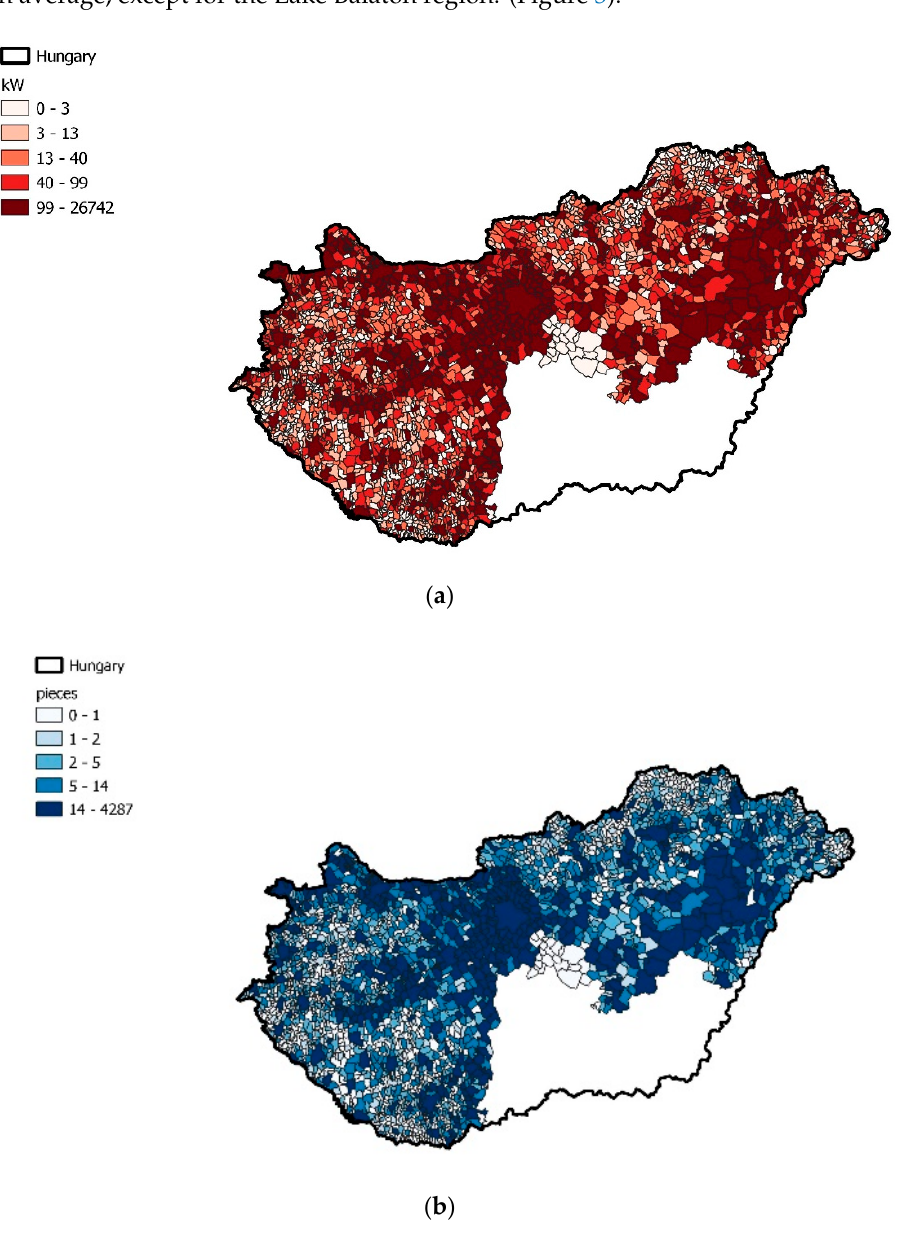
Figure 3. Total household-size small PV power plants’ (HMKE) power ( a ) and the number ( b ) of HMKEs in the settlements of Hungary.